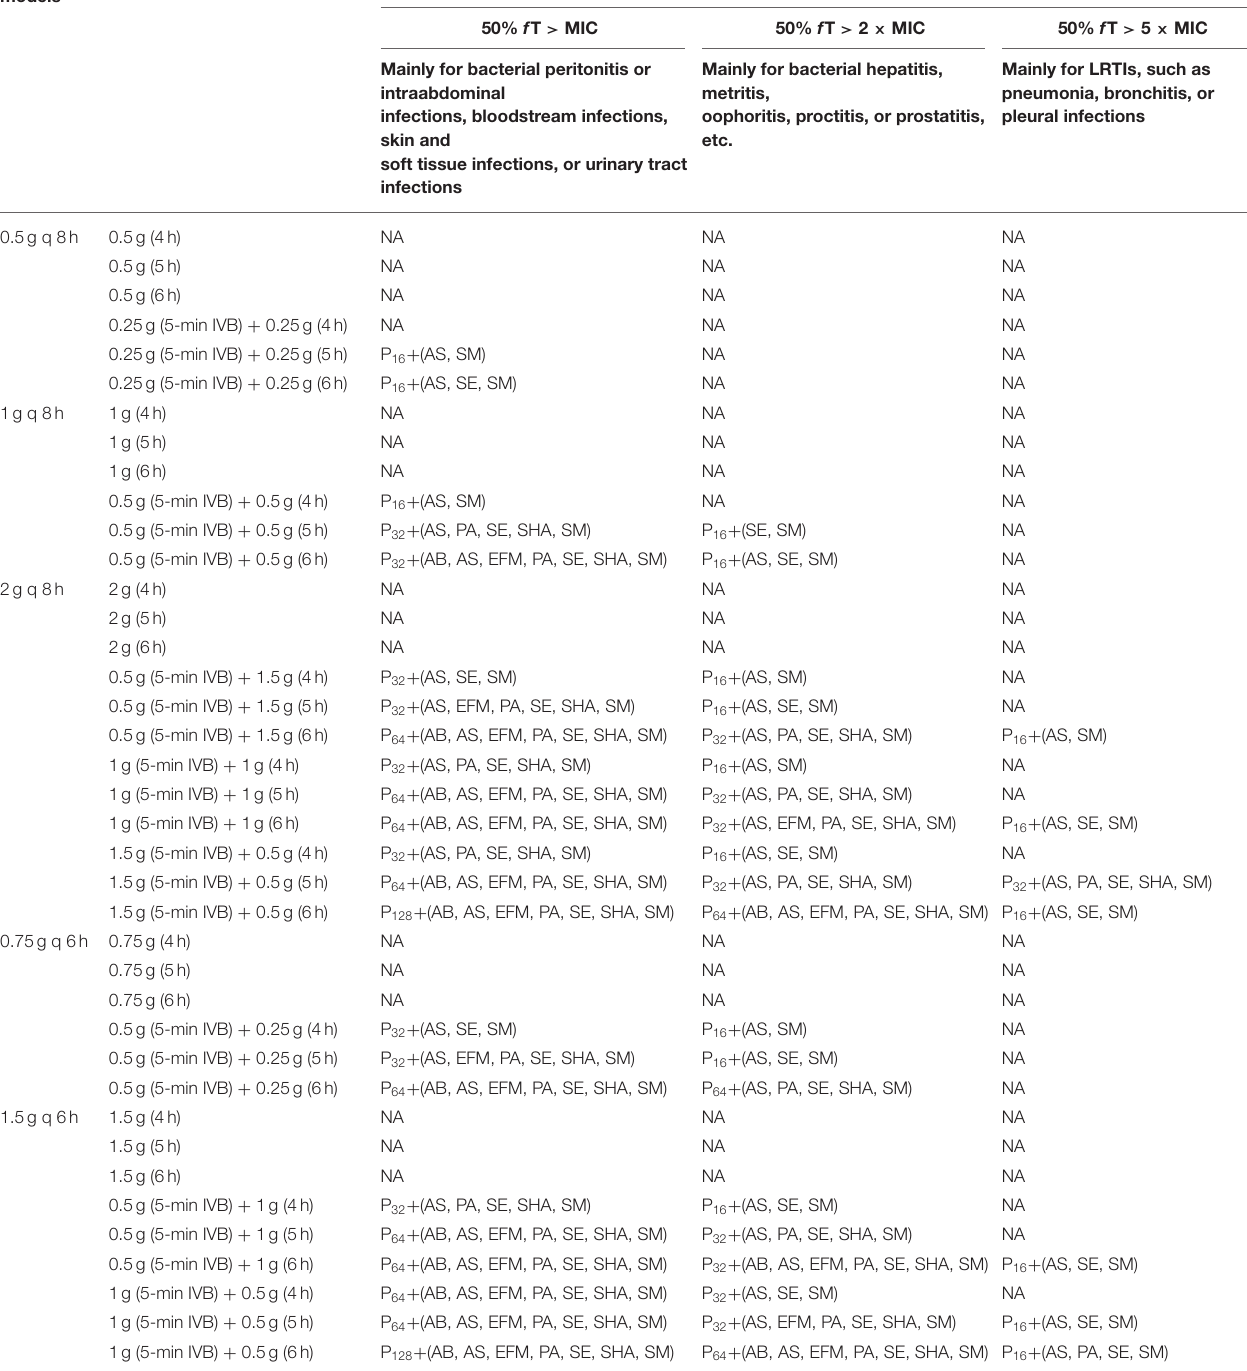
TABLE 3 | Summary of the coverage of various dosage regimens for the pathogen isolates with MICs of ≥ 16 mg/L at the condition of achieving ≥ 90% PTA and/or the targeted pathogen population with pooled MIC distributions between 16 and 512 mg/L at the condition of achieving ≥ 90% CFR in different types of infection. Dosing